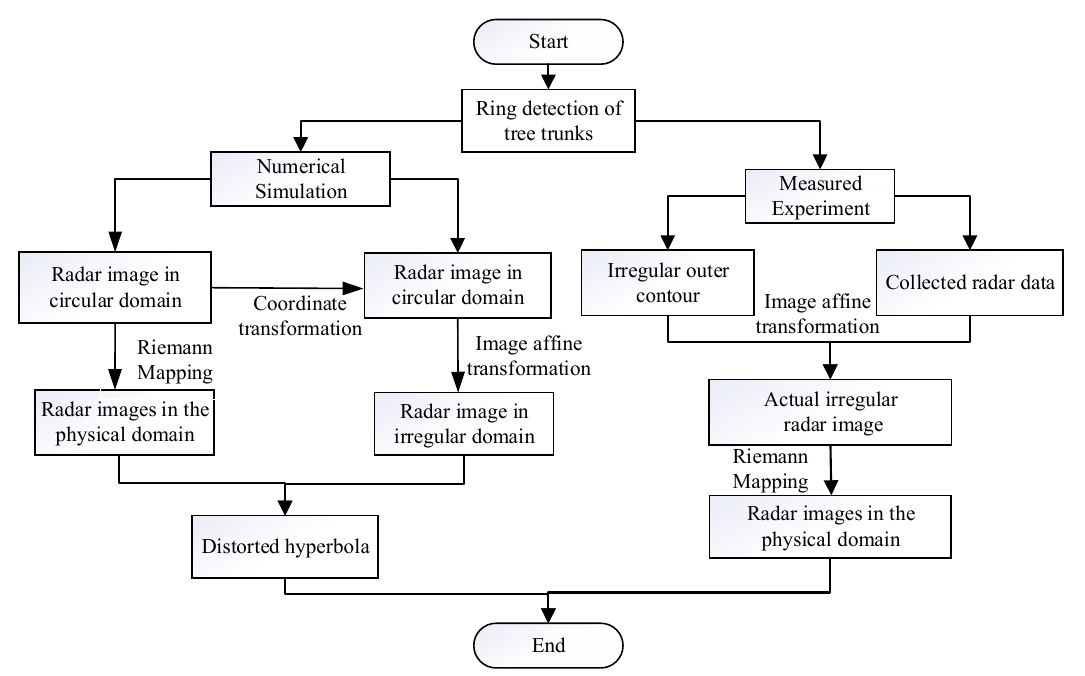
Figure 5. Processing flowchart. The left side shows the processing steps for the numerical simulation results and the right side shows the processing steps for the measured data.